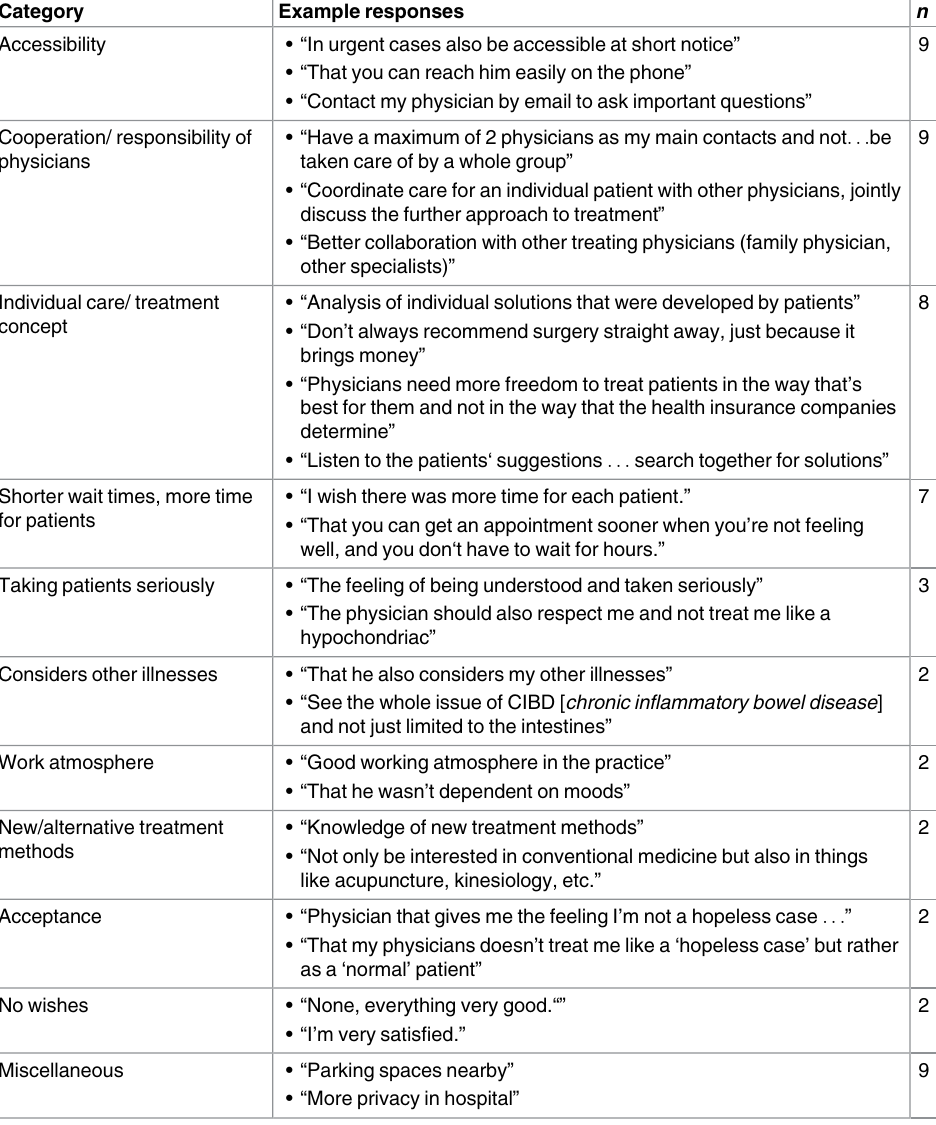
Table 3. Patients’ free-textresponses to questions about the desired qualities of health care provid- ers (translated into English by the authors). Category Example